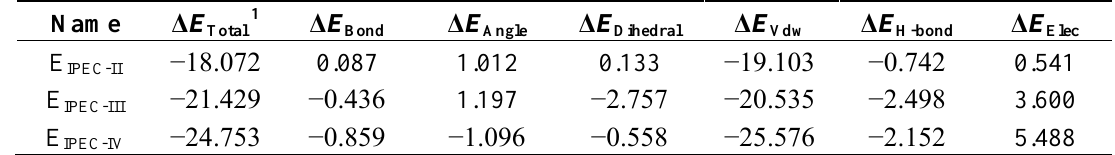
Table 2. Computational differential energy attributes calculated for the simulated IPEC system in a molecular mechanics’ force field setup performed using HyperChem™ 8.0.8